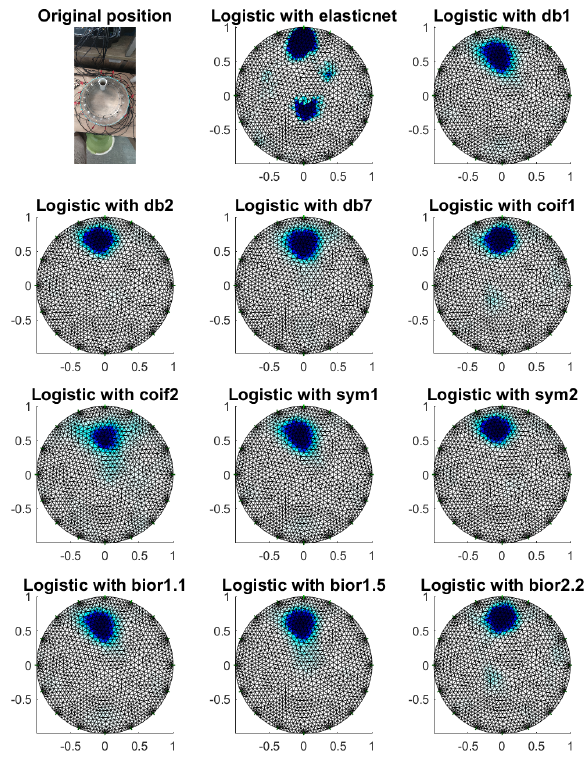
Figure 13. Image reconstruction with a phantom at electrode 1.